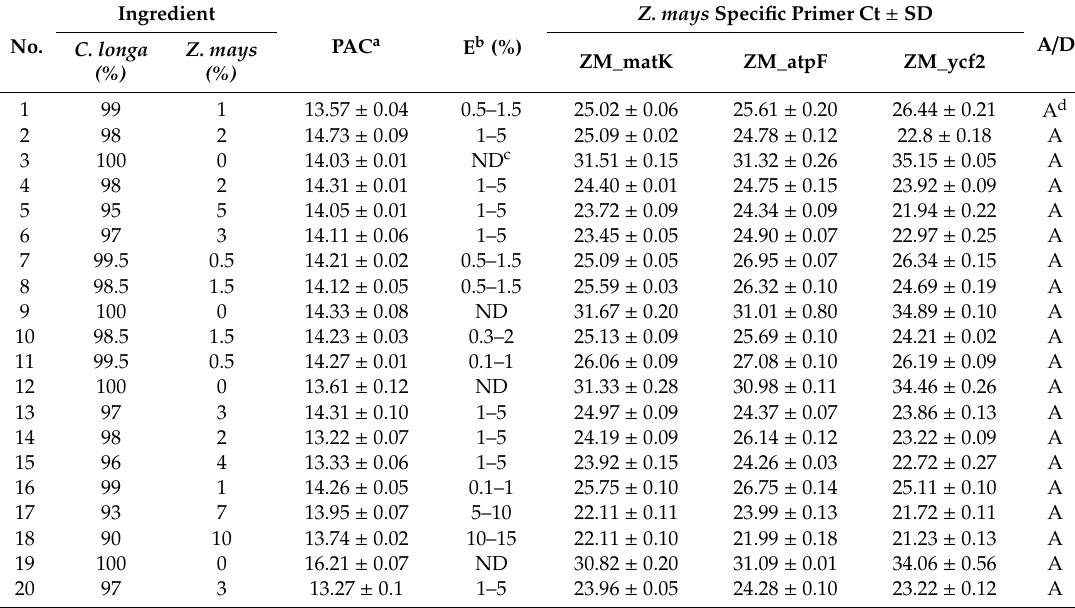
Table 3. Results of the blind mixture test for evaluating the reliability of the developed primer sets.